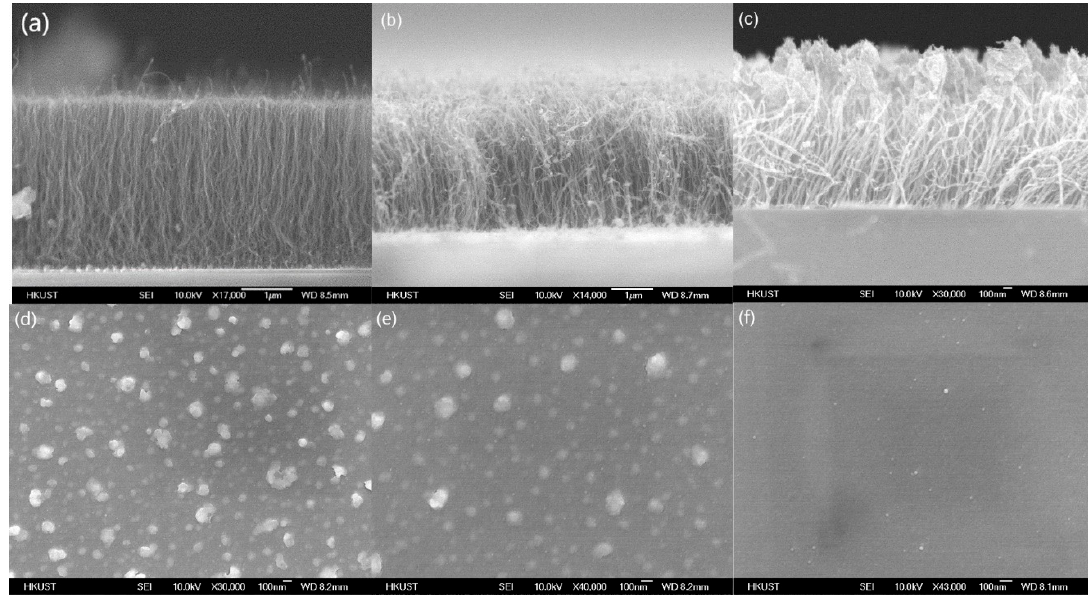
Figure 1. SEM images of vertically-aligned carbon nanotubes (CNTs) grown at ( a ) 450 °C, ( b ) 400 °C, and ( c ) 340 °C with a Ni–Al–Ni (1 nm–0.5 nm–1 nm) multilayer catalyst; and of nanoparticles annealed at ( d ) 450 °C, ( e ) 400 °C, and ( f ) 340 °C with the Ni–Al–Ni (1 nm–0.5 nm–1 nm) multilayer catalyst.